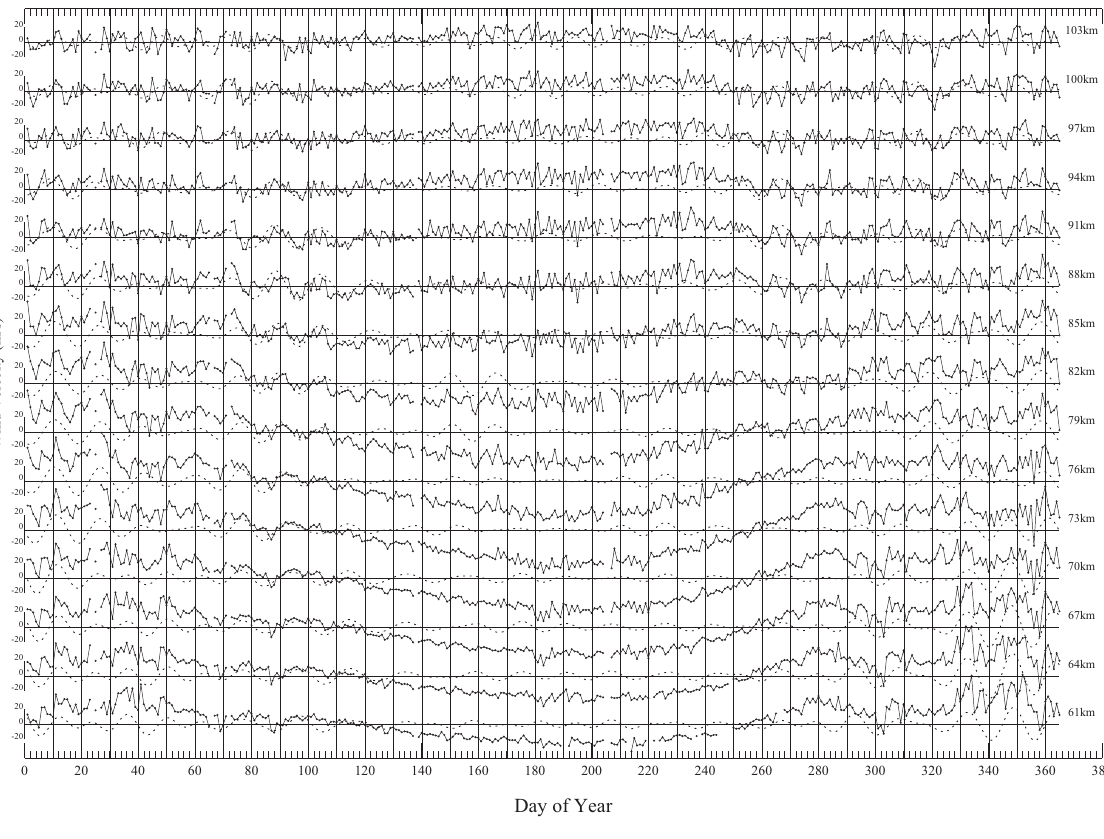
band of 11–24 days (i.e. less than 1% of the energy of those oscillations outside this band can pass through the